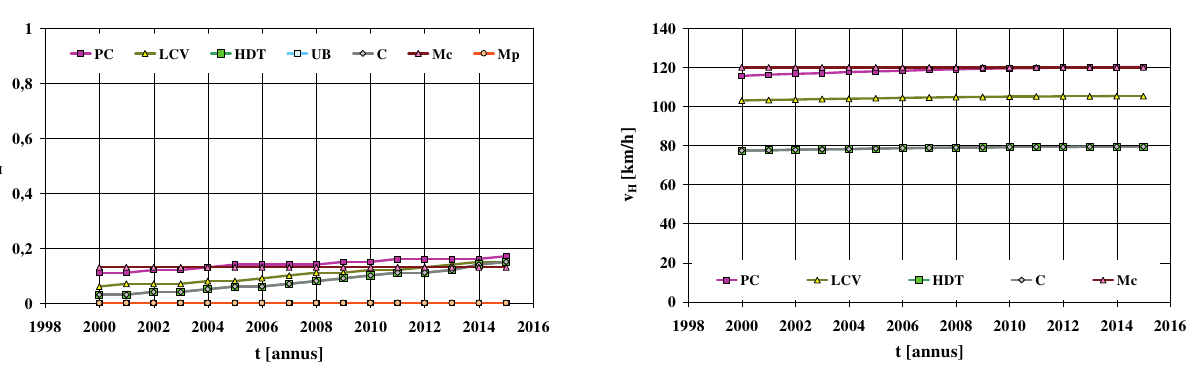
Fig. 5. Share of mileage by vehicles per cumulated category, under model traffic conditions: on highways and expressways Figures 6–8 show the assumed average vehicle velocity